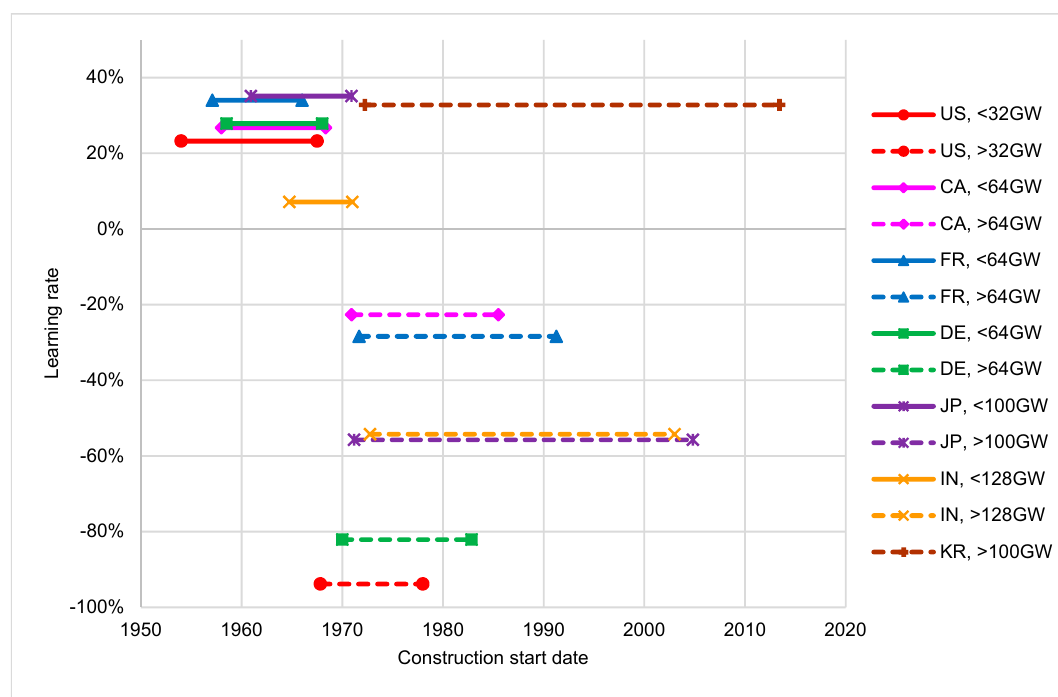
Figure 4. Learning rates pre- and post-reversal points vs. time span of construction